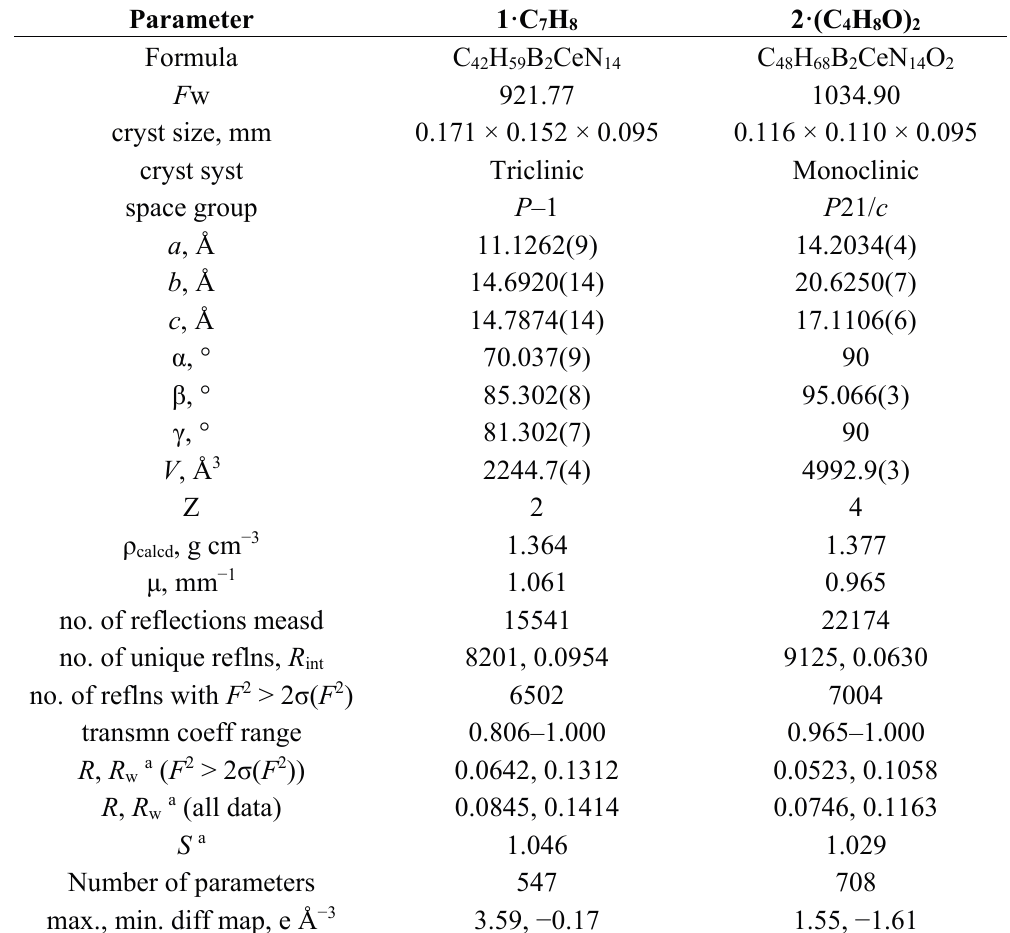
Table 2. Crystallographic data for 1 – 2